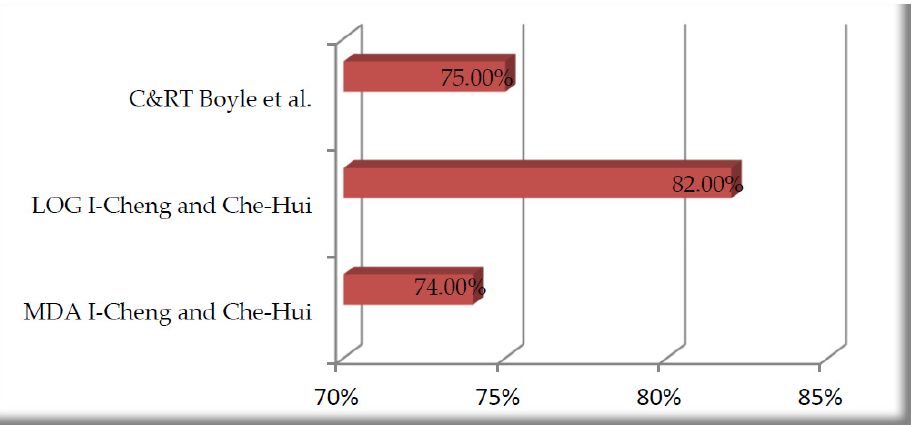
Figure 6. The comparison of effectiveness of the forecasting models. Source: based on own studies.